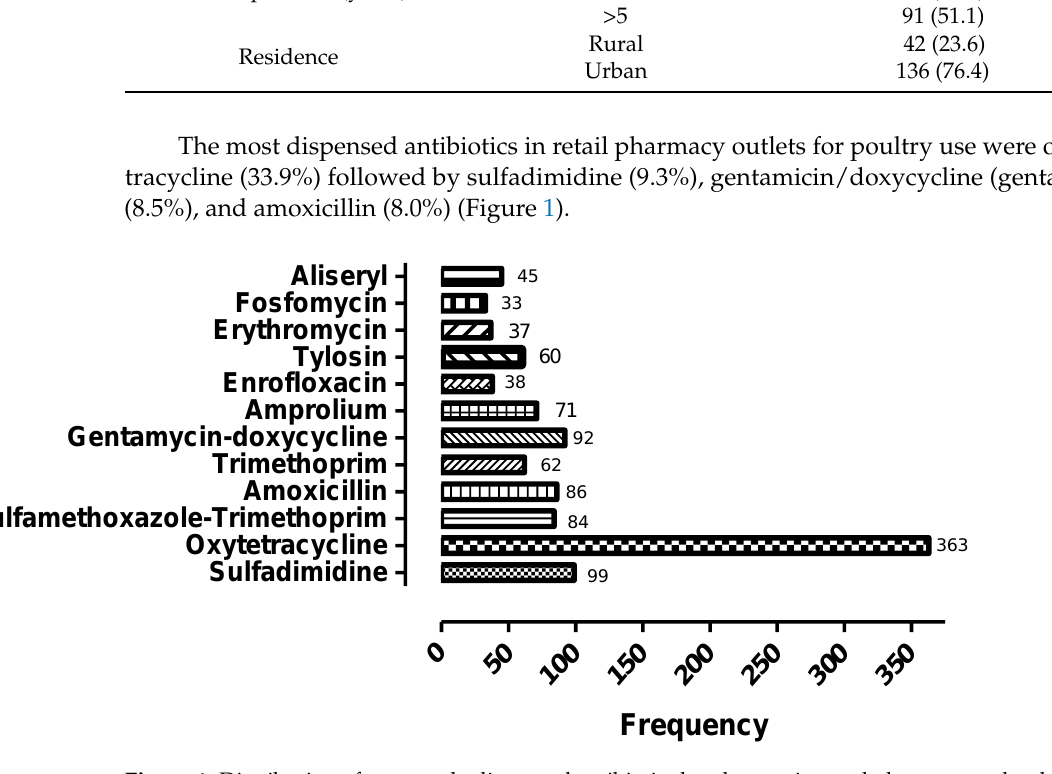
Figure 1. Distribution of commonly dispensed antibiotics by pharmacists and pharmacy technolo- gists.